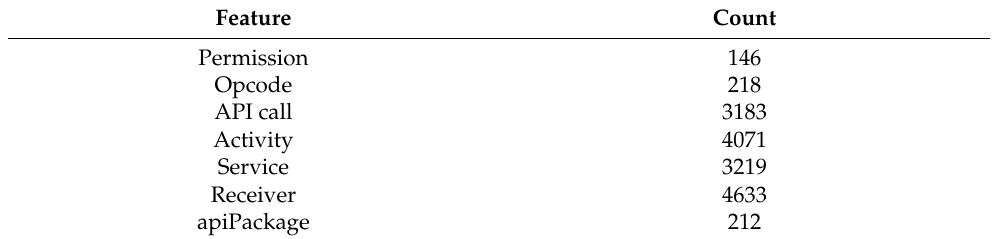
Table 2. Number of dataset features.